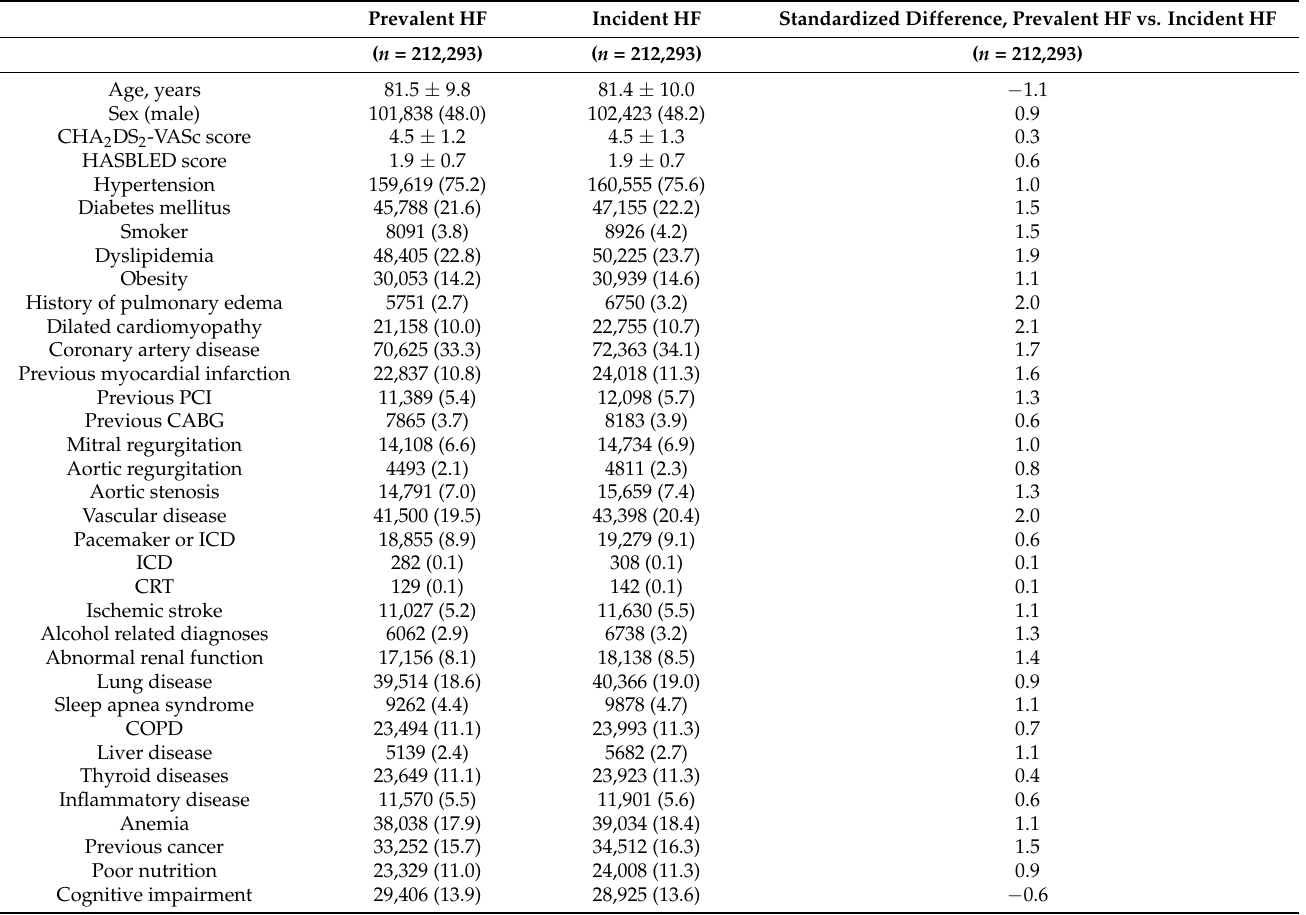
Table 3. Baseline characteristics of matched patients with AF and prevalent HF or incident HF.